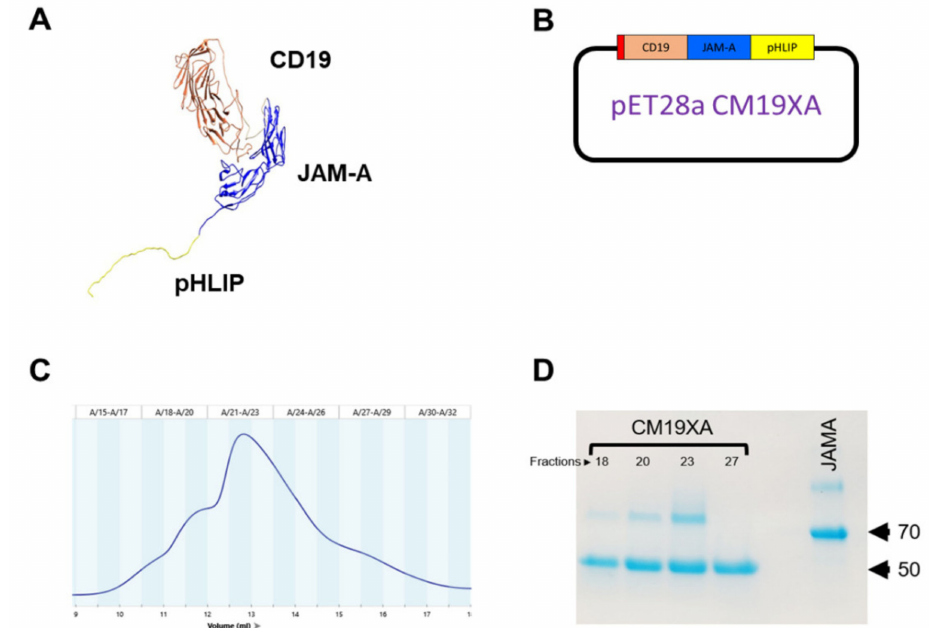
Figure 1. CM19XA modeling and purification. ( A ) Computer model of CM19XA. CM19XA consists of CD19 (coral), GS linker (Gray), JAM-A (blue), and pHLIP peptide (yellow). ( B ) Plasmid (pET28a) hosting CM19XA, contains a 6xHis tag, N-terminal to CD19. ( C ) Size-exclusion chromatogram of CM19XA purification. ( D ) Coomassie stain of CM19XA purified fractions and JAM-A as a